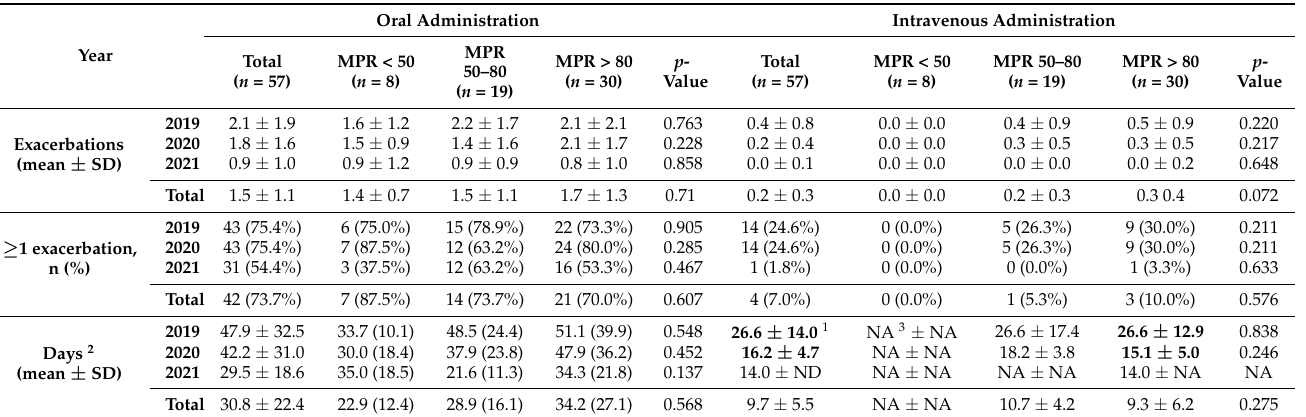
Table 2. Mean number of respiratory exacerbations with oral and intravenous cycles in each year of the study and in total.